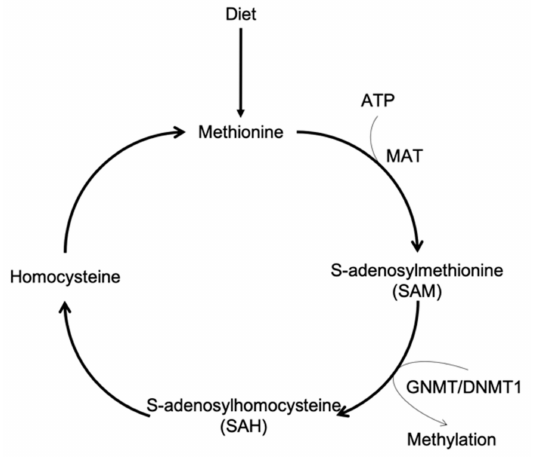
Figure 1. Schema of methionine (MET)